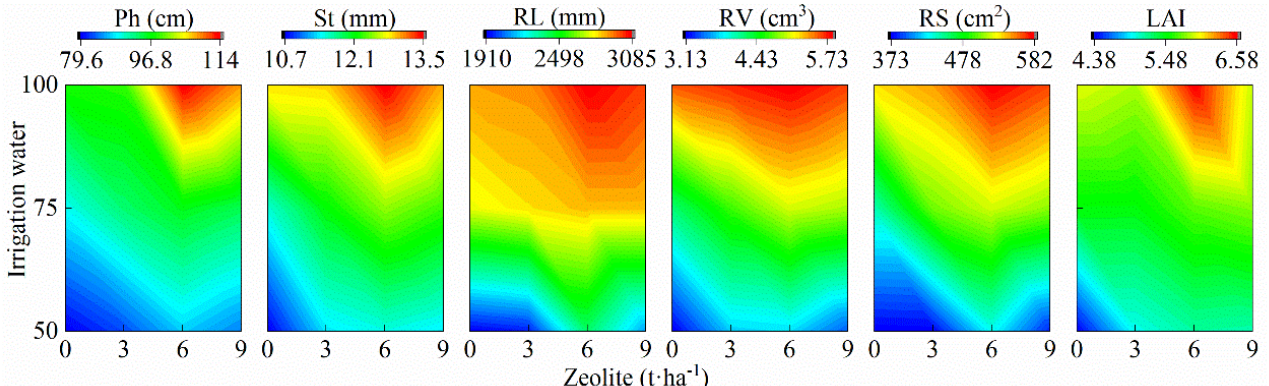
Figure 2. Effects of W - Z on tomato growth during alternate drip irrigation under mulch. Ph , St , RL , RV , RS , and LAI represent plant height, stem thickness, root length, root volume, root surface area, and leaf area index, respectively.